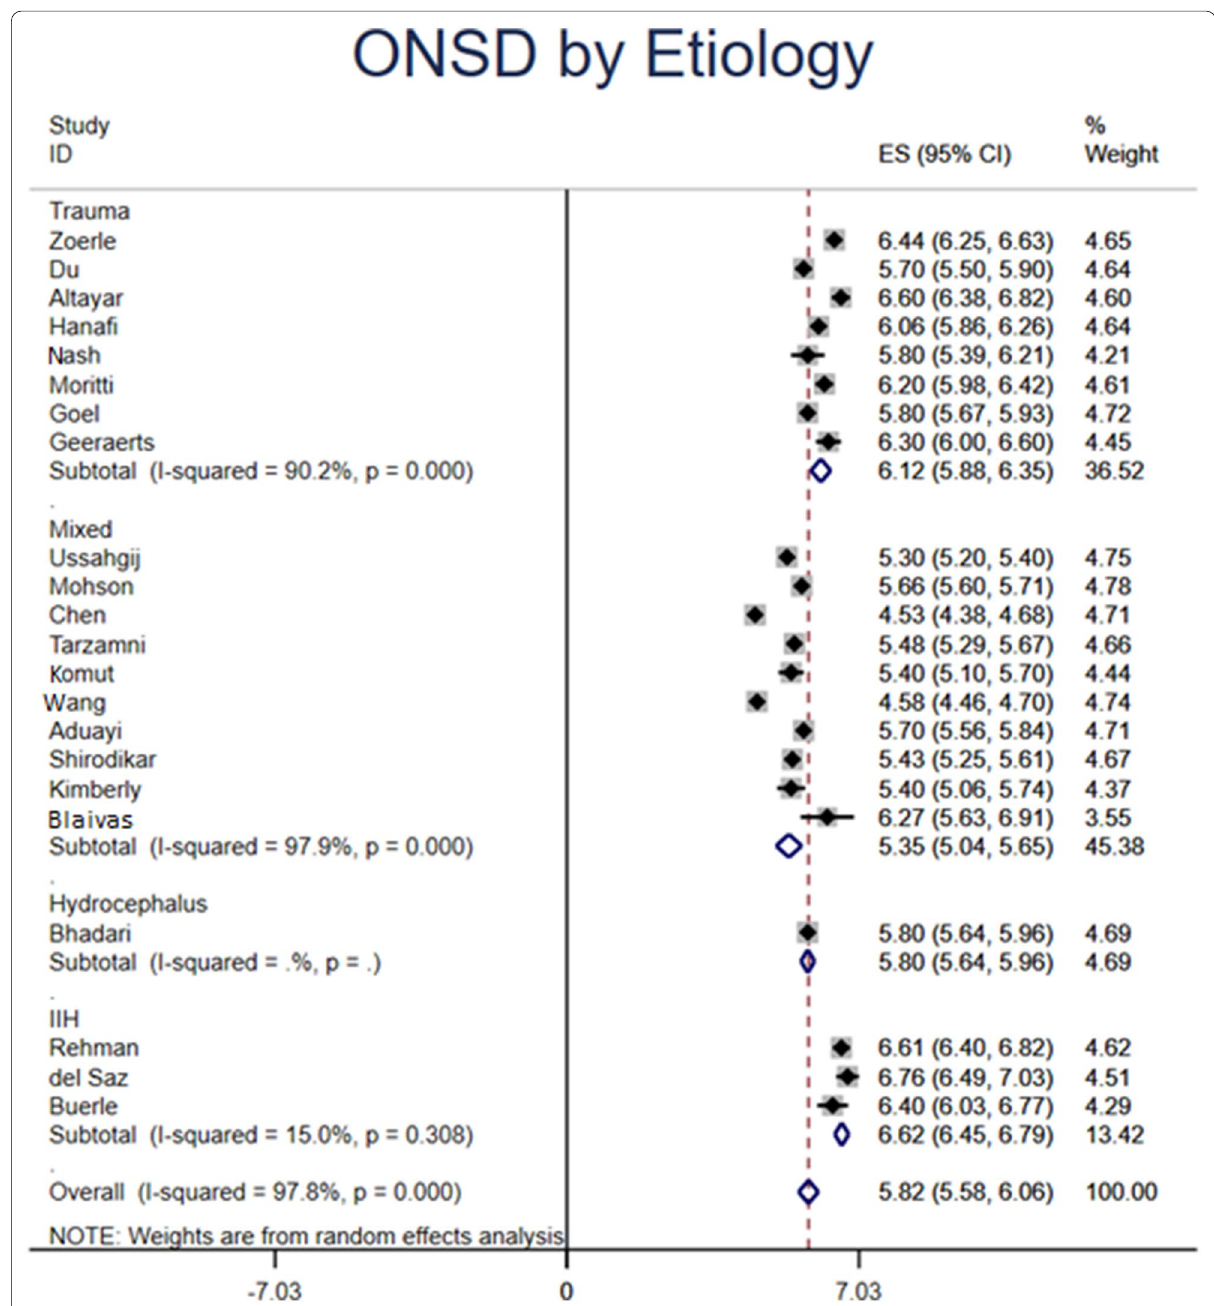
Fig. 5 Optic nerve sheath diameter (ONSD) measured by ultrasound (US) stratified by etiology of elevated intracranial